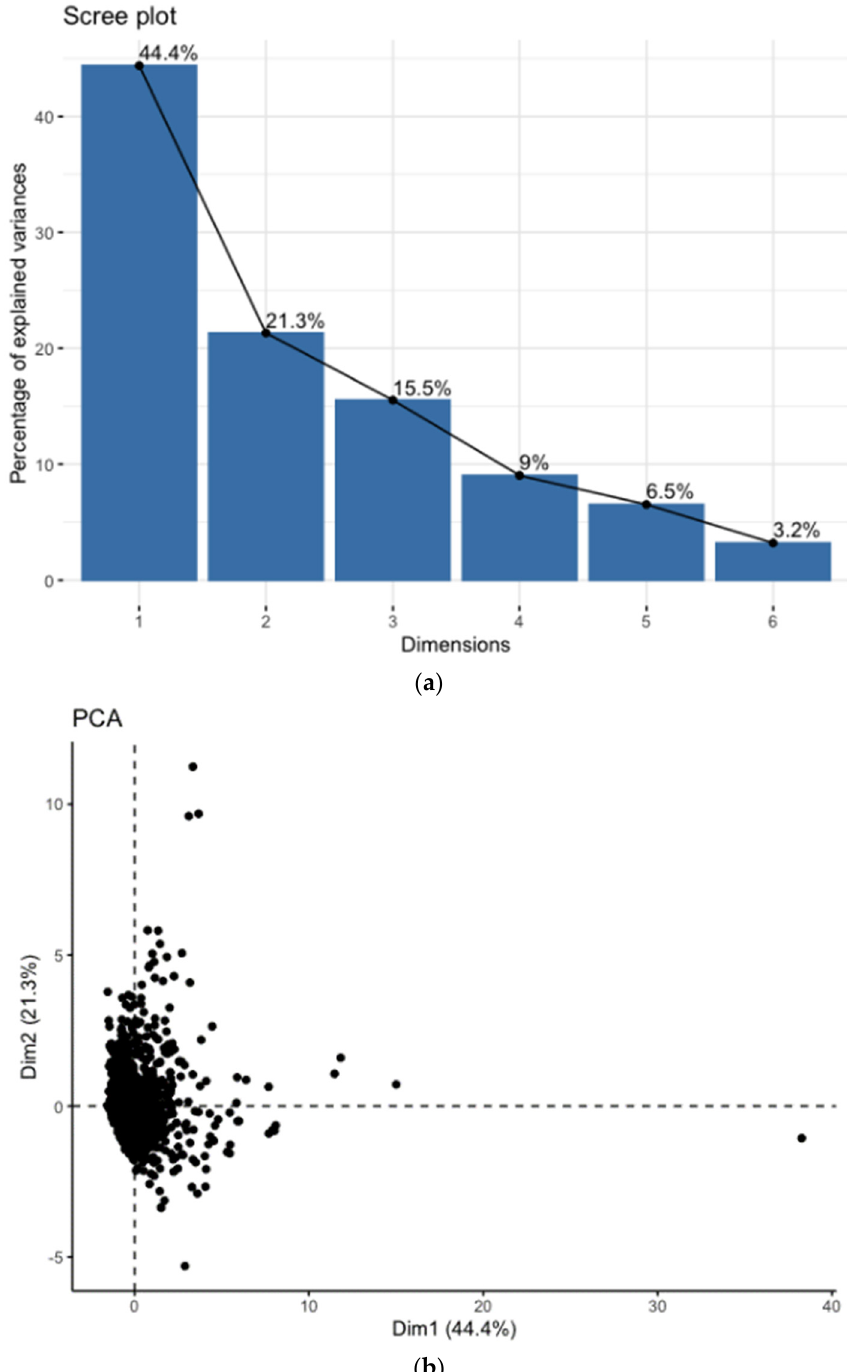
Figure 3. Explained variance of the PCs ( a ) and municipalities’ data in the space of the first two PCs ( b ). Table 1. Correlation between the structural variables of the municipalities.